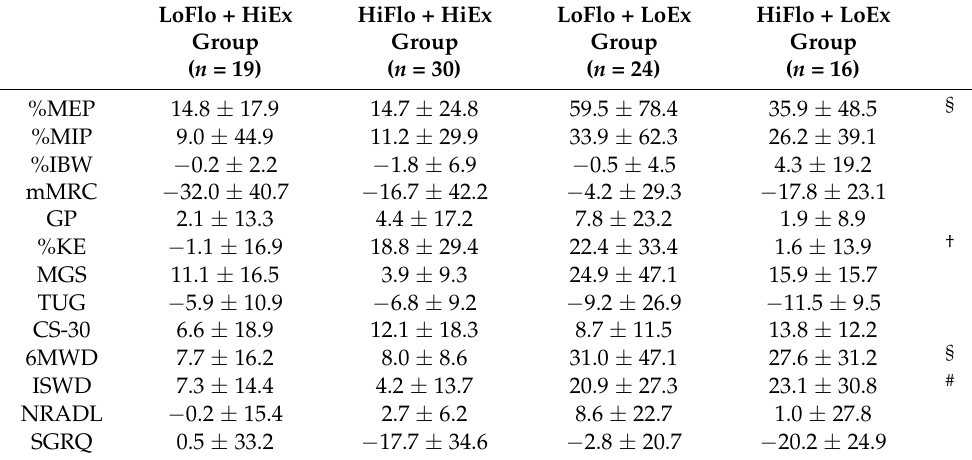
Table 3. Comparison of the rate of change between LoFlo + HiEx, HiFlo + HiEx, LoFlo + LoEx, and HiFlo + LoEx groups. LoFlo + HiFlo + HiEx LoFlo + HiEx Group Group ( n = 30) ( n = 19)